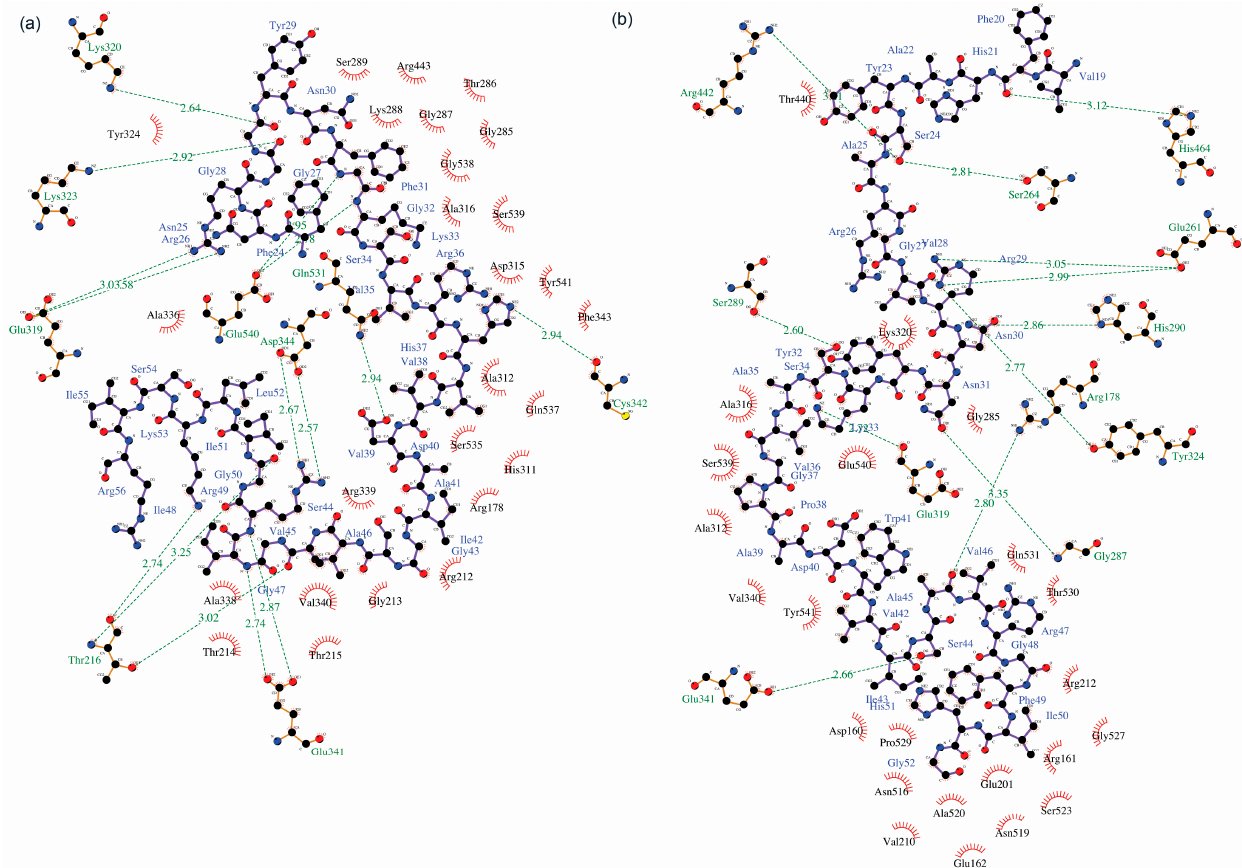
Figure 9. Ligplot + interaction diagram of ( a ) PlnE and ( b ) PlnF where hydrogen bonding is represented by the green dotted line and hydrophobic interaction represented in